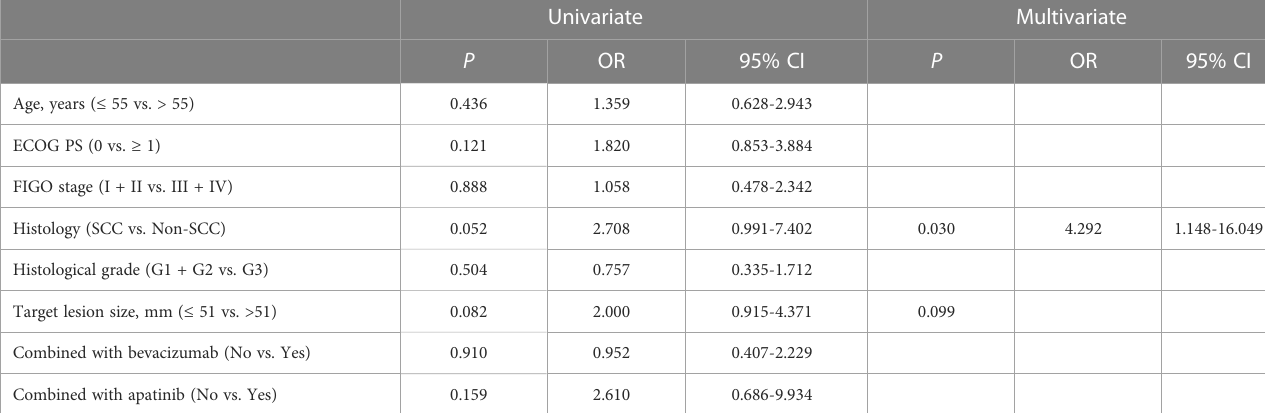
TABLE 5 Univariate and multivariate analyses of the antitumor response (CR + PR). Univariate Multivariate P OR 95%